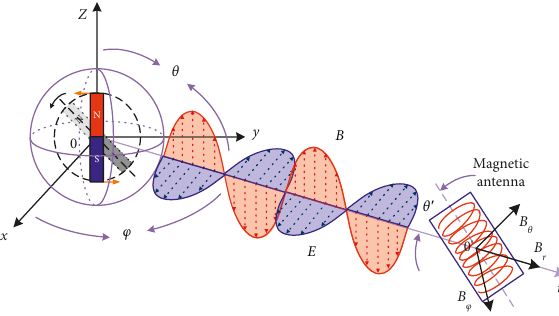
Figure 2: Diagram of the magnetic antenna receiving electromagnetic